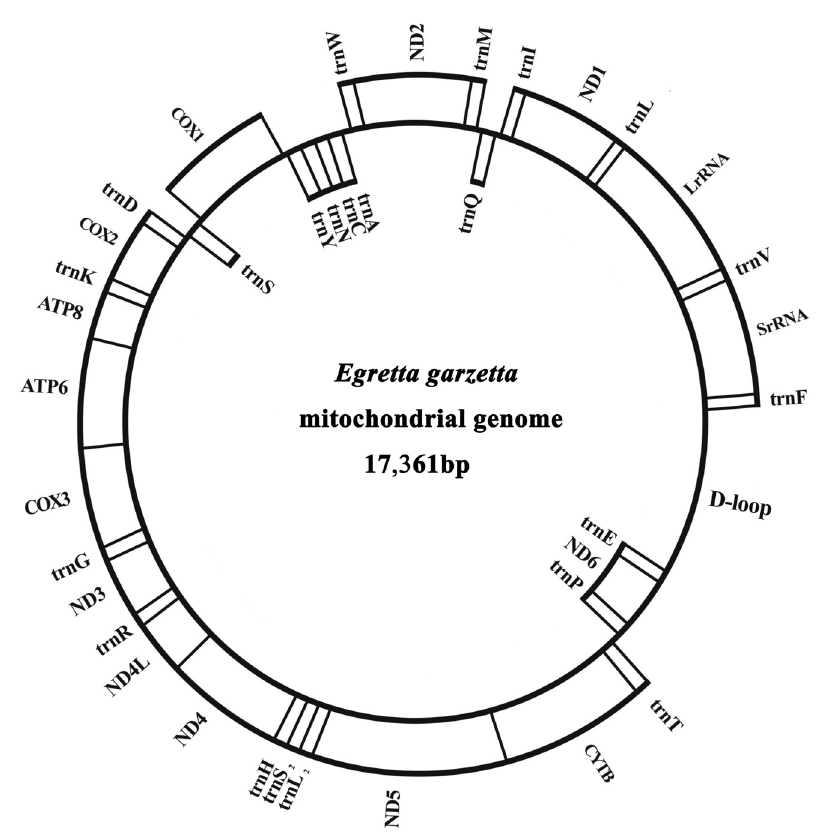
Figure 1 - Gene organization of the E. garzetta mitogenome. ND 1-6 refers to NADH dehydrogenase subunits 1-6, CO I-III refer to cytochrome c oxidase subunits 1-3, ATP6 and ATP8 refer to ATPase subunits 6 and 8, and Cyt b refers to cytochrome b. Twenty-two tRNA genes are designated by single-letter amino acid